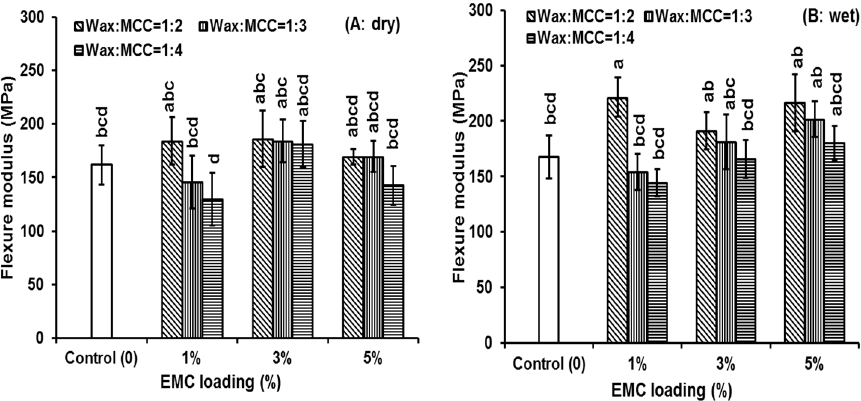
Figure 4. The flexure properties of epoxy and EMC/epoxy composites before ( A : dry); and after ( B : wet) immersion in distilled water for 24 h. Means with the same letter (a–d) are not significantly different at 0.05. Both dry and wet samples were compared together.